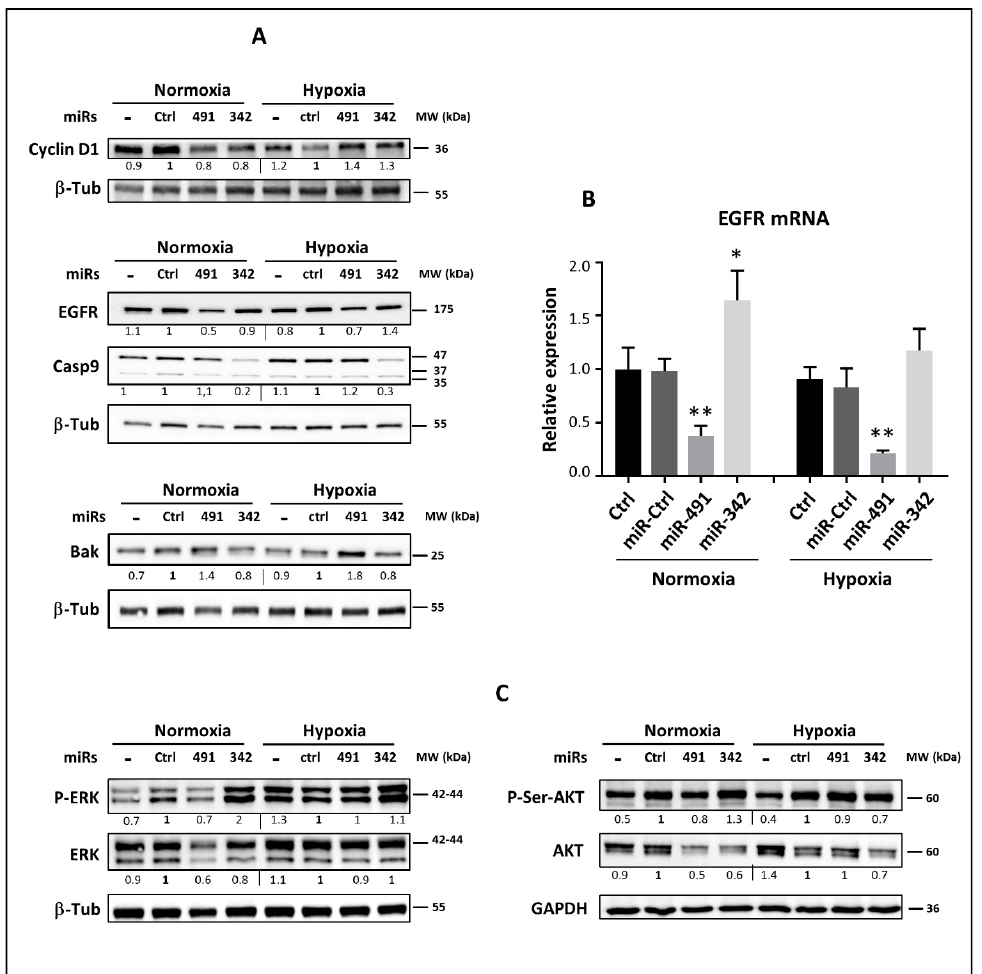
Figure 8. Analysis of some survival/death proteins and mitogenic signaling pathways affected by miR-491-5p and miR-342-5p. SW1353 cells were cultured and transfected as described in Figure 5. Analyses were carried out 72 h post-transfection. ( A , C ) Protein extracts were analyzed with Western blots to evaluate the levels of Cyclin D1, EGFR, Caspase-9, Bak, P-Thr202/Tyr204-ERK, ERK, P-Ser473-AKT and AKT versus β -tubulin ( β -Tub) or GAPDH. Representative blots of three independent experiments are shown. Protein expressions are indicated at the bottom of the blots. They were normalized to β -tubulin or GAPDH, and to the corresponding miR-Ctrl for each oxic condition. ( B ) Total RNA was extracted as described in the Materials and Methods section. Relative expression of EGFR was determined by RT-quantitative PCR and normalized to both PPIA1 and GAPDH levels and to Ctrl. Data are expressed as mean of triplicate samples ± SD. The results are representative of three independent experiments. The significance of the results was evaluated by two-tailed Student’s t -test compared with the corresponding miR-Ctrl (*: p < 0.05, **: p < 0.01).